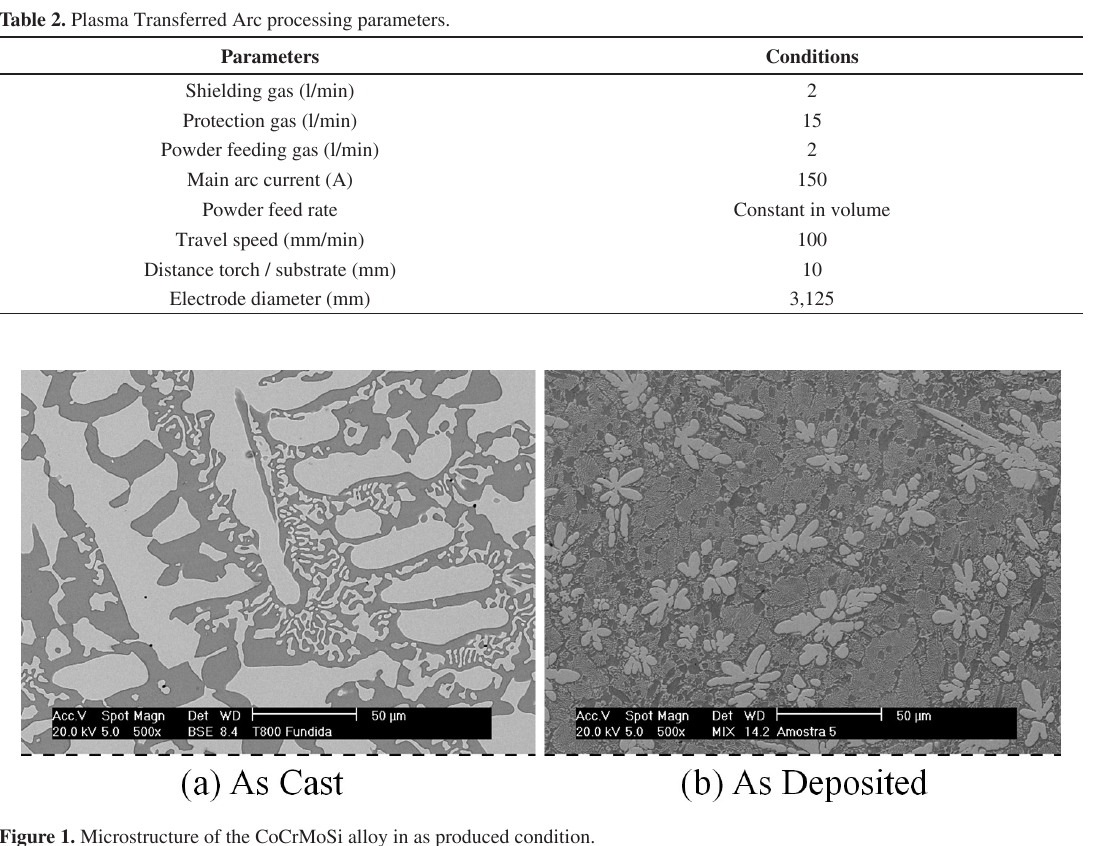
Figure 1. Microstructure of the CoCrMoSi alloy in as produced